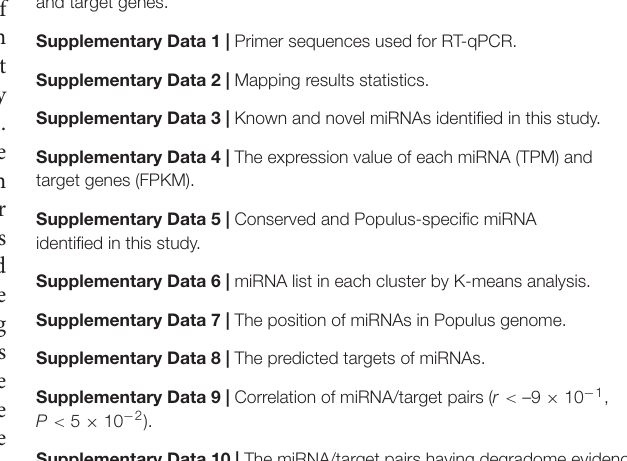
Supplementary Figure 1 | Hairpin structure of 21 novel miRNAs. Supplementary Figure 2 | Validation of identified expression of miRNAs and target genes. Supplementary Data 1 | Primer sequences used for